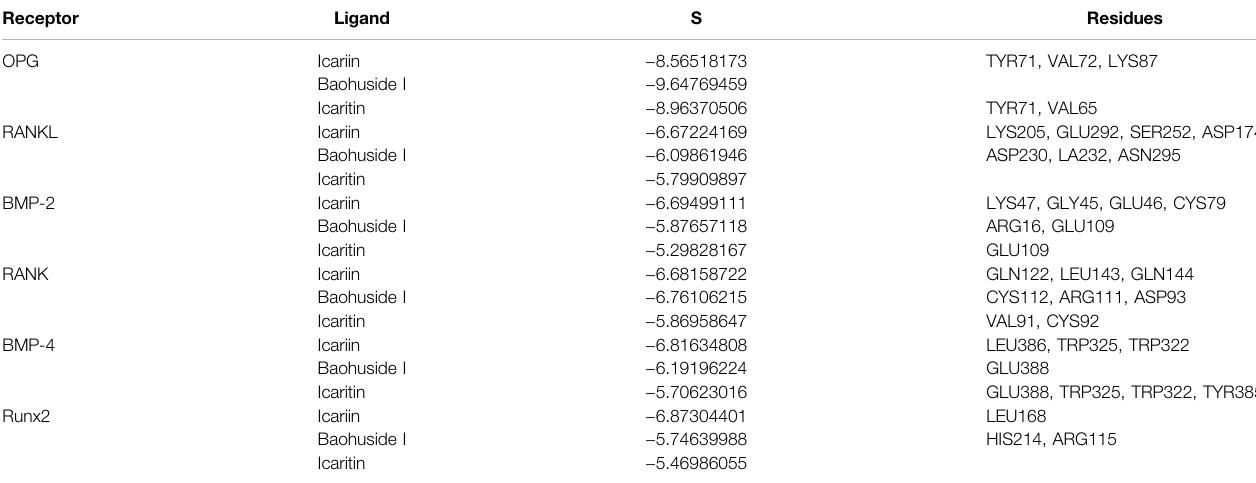
TABLE 2 | Docking scores and interacting residues between receptors and